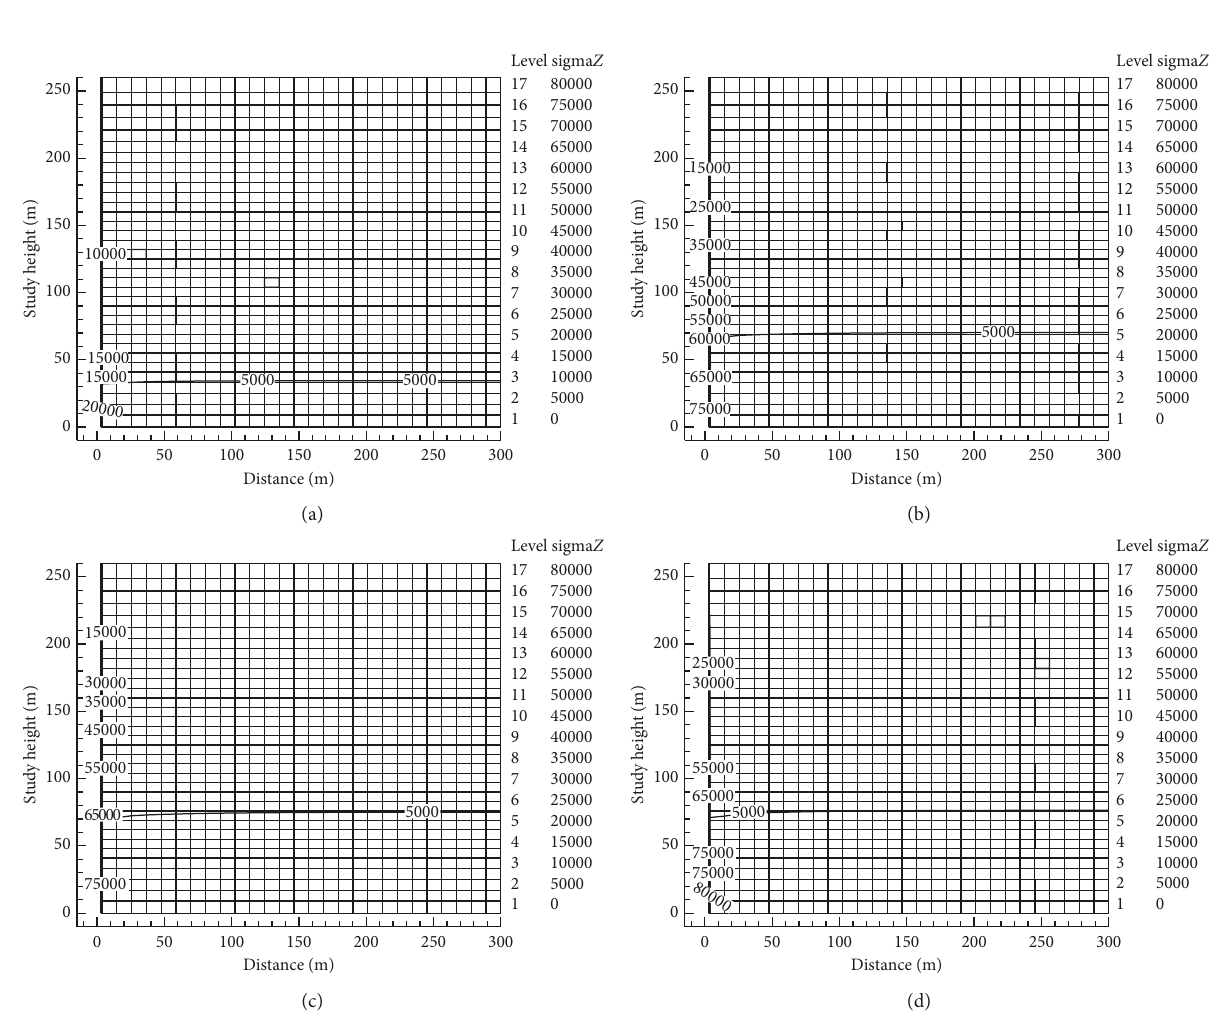
Figure 6: Vertical stress state of the shaft wall under different load levels: (a) third load level; (b) fifth load level; (c) seventh load level; (d) ninth load level (stress unit KPa).